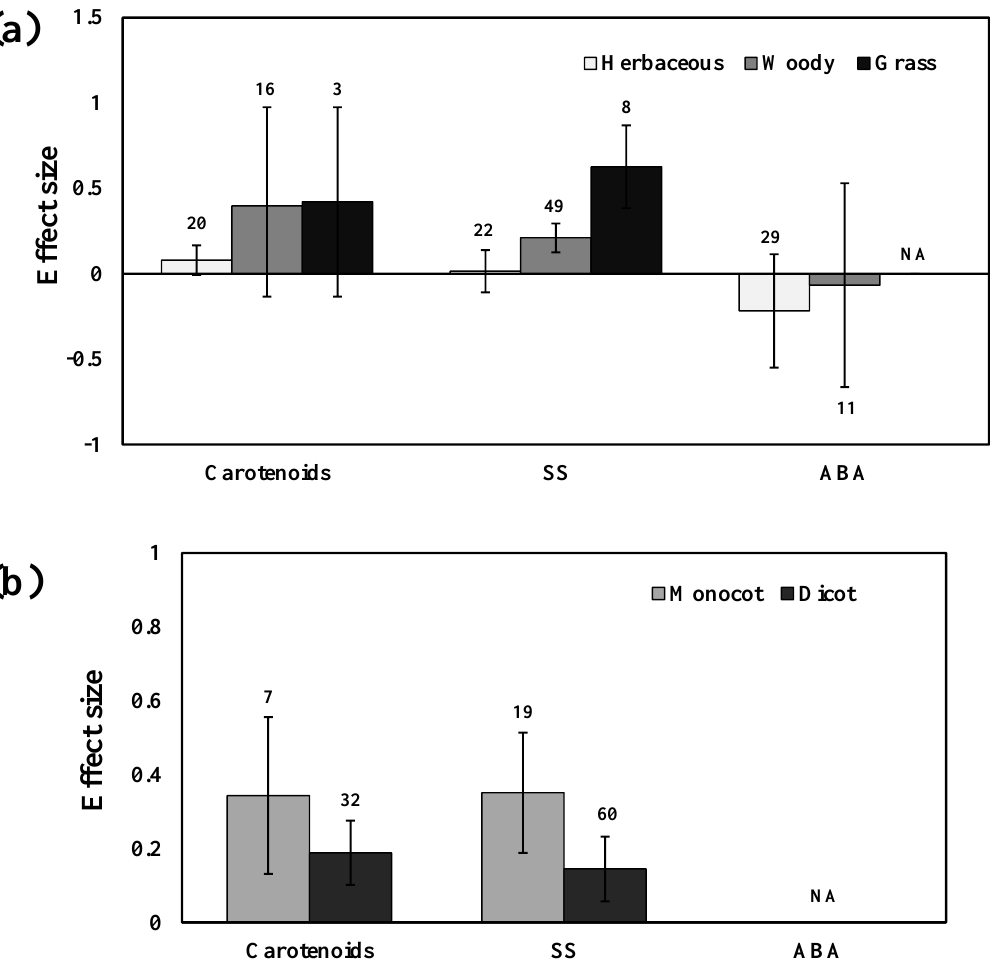
Figure 10. Categorical analysis of plant functional groups ( a ) and taxonomical groups ( b ) on CAR, SS, and ABA levels. Error bars are means ± 95% confidence intervals (CIs). Where the CIs do not overlap the horizontal lines, the effect size for a response variable is significant at p < 0.05. The numbers of observations are shown above the bar. Note: CAR—Carotenoids, SS–Soluble sugars, ABA—Abscisic acid.